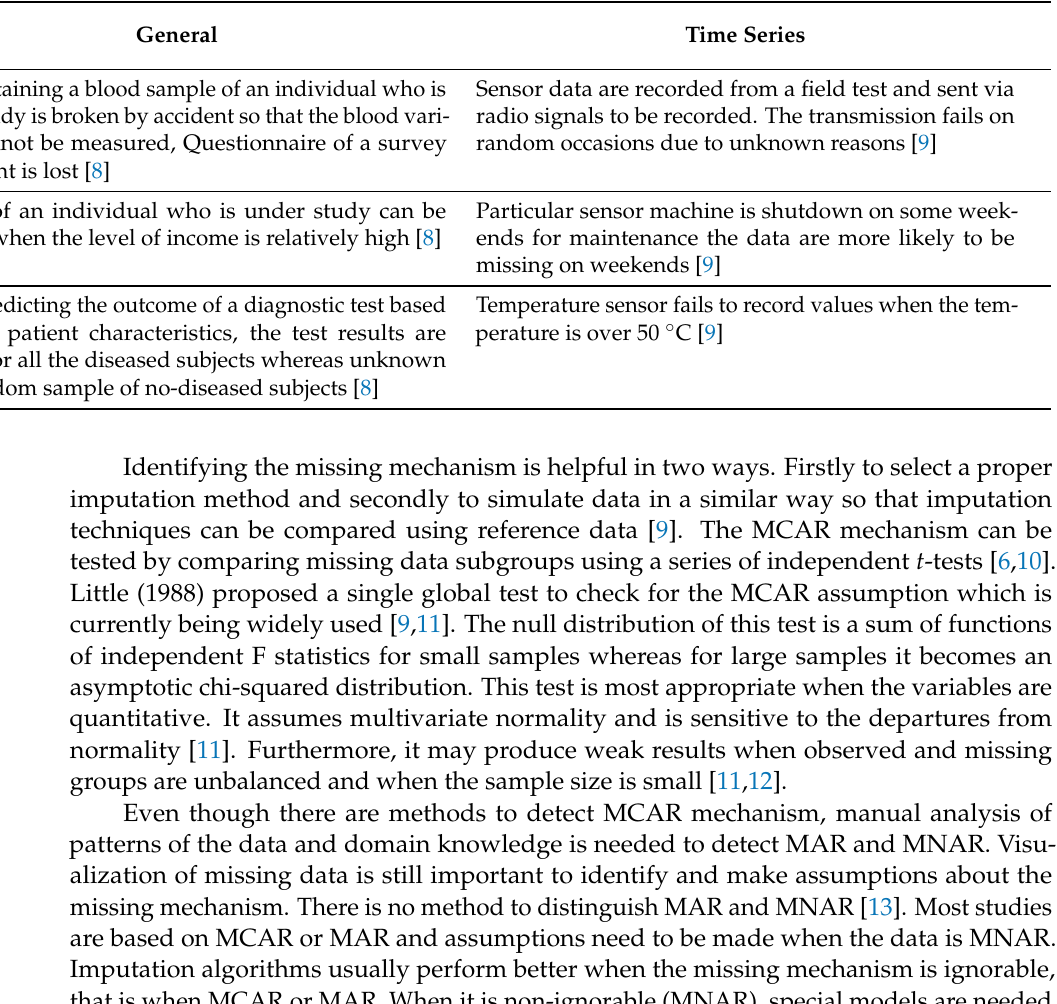
Table 1. Examples for each missing mechanism under general setting and time series